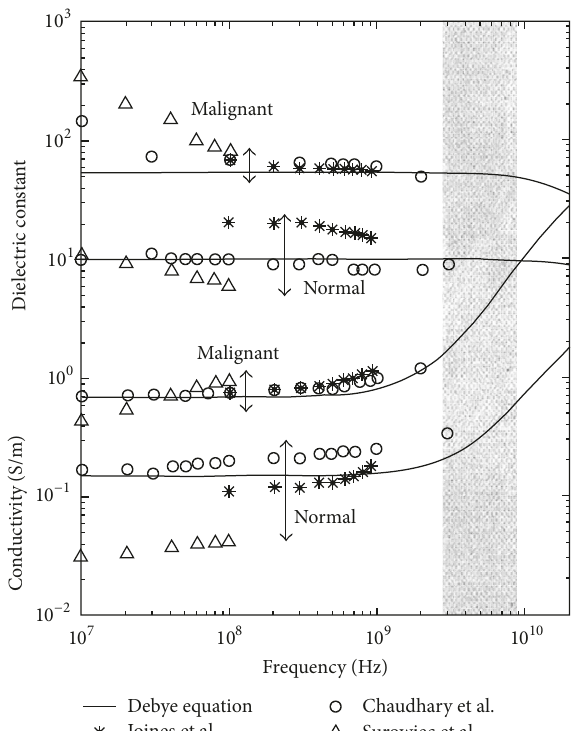
Figure 3: Dielectric properties data for normal and malignant breast tissue at radio and microwave frequencies and single-pole Debye curve fits of measured baseline [9]. Image copyright IEEE, used with